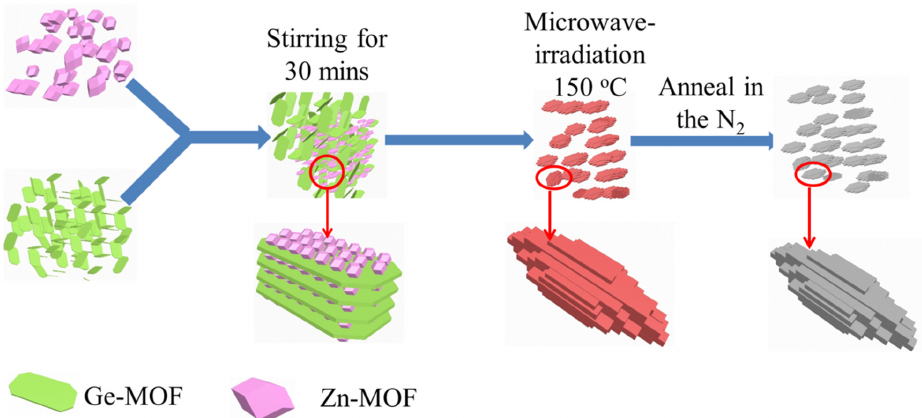
Figure 1. Schematic diagram of the microwave-assisted synthesis of metal-organic frameworks derived rice-like Zn 2 GeO 4 nanowire bundles.